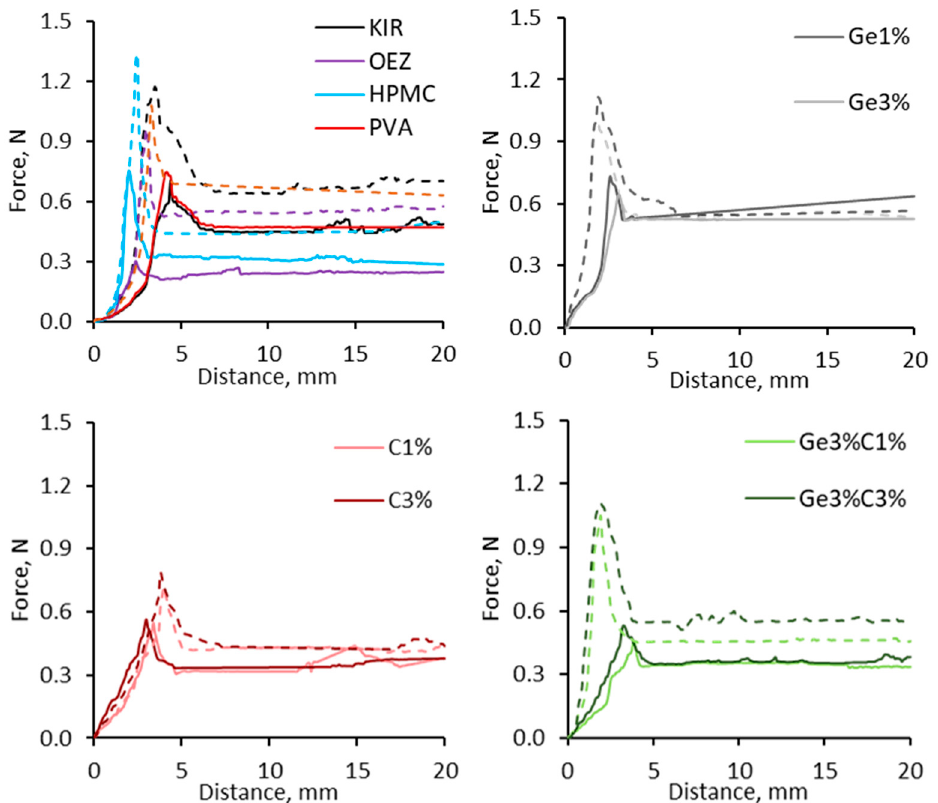
Figure 4. Graphs to show the in vitro oral gliding performance and shear adhesion profile of various film-coated tablets using a modified Hounsfield tensometer across an in vitro, non-anatomical model using artificial saliva wetted sodium polyacrylate (dashed lined) and polytetrafluoroethylene ramp surface (solid lines). HPMC and PVA possessed higher initiating detachment forces and displayed a greater gliding resistance in comparison to Opadry ® EZ (OEZ), which possessed the most optimal slippery profile in comparison to all film-coated formulations (ANOVA, p < 0.05). The addition of water-soluble polymers within KIR (Kollicoat ® IR) imparted lubricating properties, as substantially lower peak forces and gliding forces were recorded.